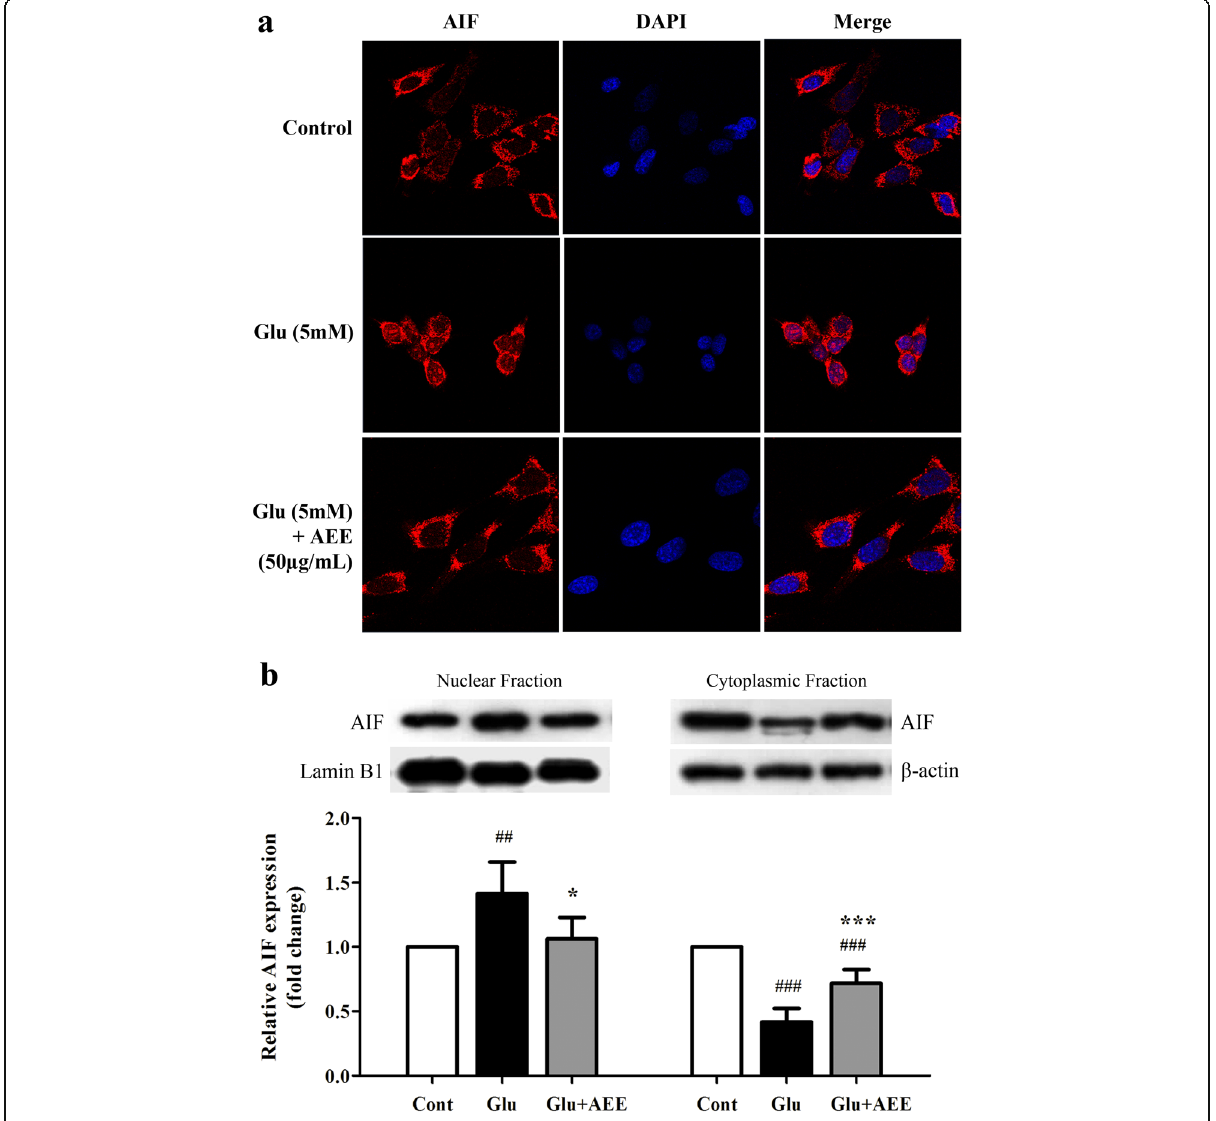
Fig. 4 Effect of AE leaf extract on subcellular distribution of AIF in glutamate-treated HT22 cells. ( a ) Representative confocal photographs of immunofluorescence staining with an antibody specific for AIF (red) and nuclei counterstaining with DAPI (blue) of untreated HT22 cells (control; top panel) or cells exposed to 5 mM glutamate alone (middle panel) or glutamate combined with 50 μ g/mL AEE (bottom panel) for 16 h. ( b ) Western blot analysis of AIF protein in nuclear and cytoplasmic fractions isolated from HT22 cells exposed to the similar treatment conditions as in ( a ). Lamin B1 and β -actin were used as endogenous loading controls to normalize the expression level of AIF protein from nuclear and cytoplasmic fractions, respectively. Data are expressed as the means ± SD, ## P <0.01, ### P <0.001 vs. control; *P <0.05, ***P <0.001 vs. glutamate